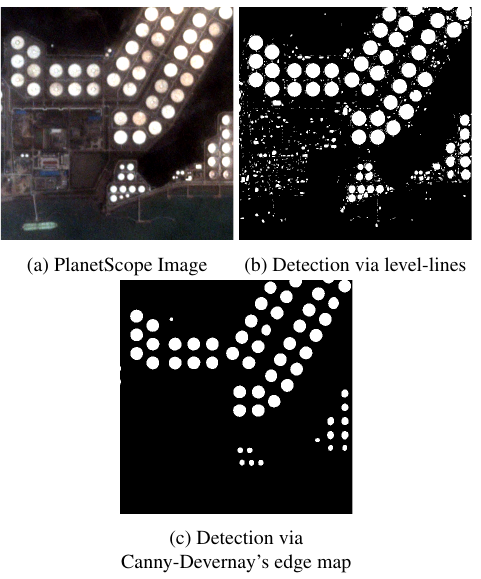
Figure 13. Tank detection on a PlanetScope